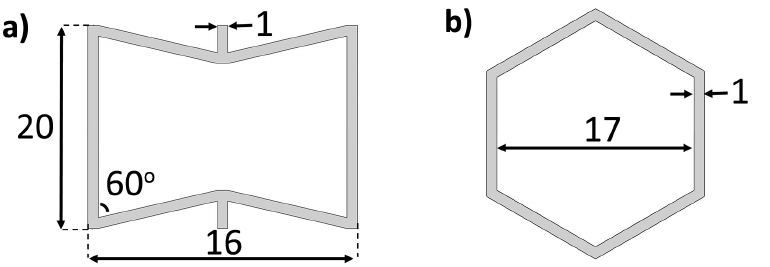
Figure 1. Unit cell dimension of ( a ) re-entrant and ( b ) regular honeycomb lattice structures.